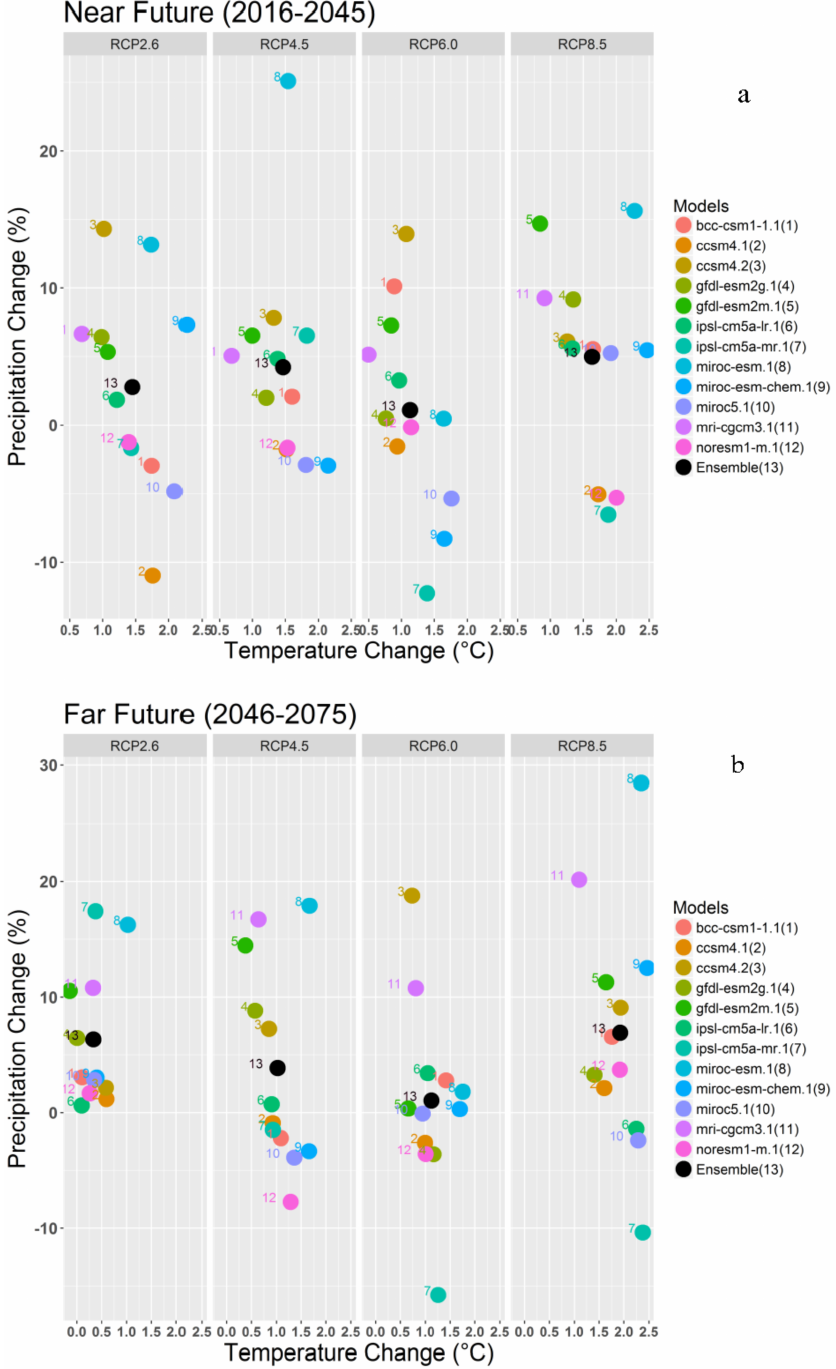
Figure 5. Change in average yearly temperature and total precipitation relative to the baseline (1981–2010) for the periods ( a ) Near Future (2016–2045) and ( b ) Far Future (2046–2075) for all the